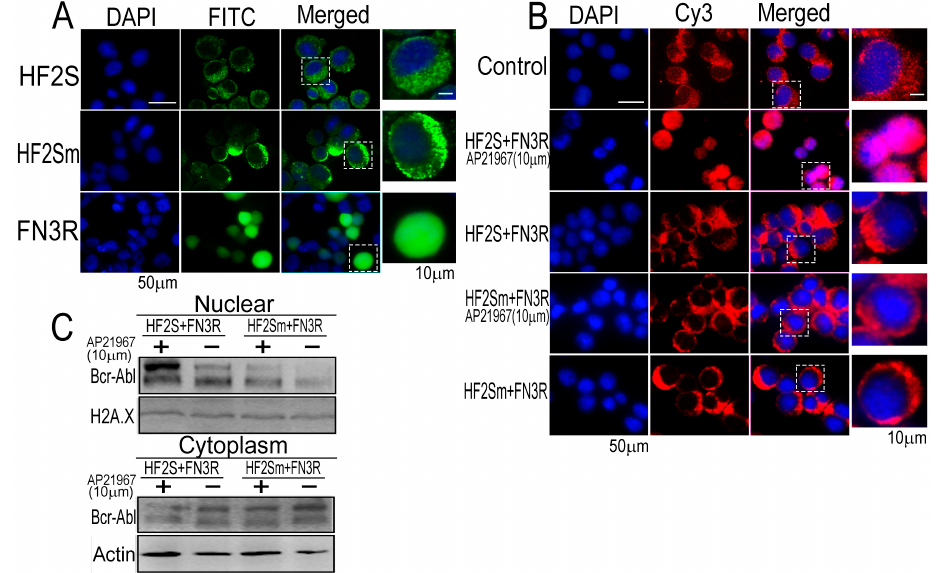
Figure 2. Bcr-Abl was imported into nucleus successfully by the nuclear transport system: ( A ) the location of exogenous HF2S, HF2Sm and FN3R fusion protein in K562 cells. Cells were treated with adenoviral Ad5/F35-HF2S, Ad5/F35-HF2Sm and Ad5/F35-FN3R, and stained with anti-HA/anti-Flag antibody fluorescein isothiocyanate(FITC)-labeled goat anti-mouse IgG, followed by DAPI (4 ′ ,6- diamidino-2-phenylindole) counterstaining and merged for each images; ( B ) immunofluorescence of Bcr-Abl with K562 cells treated with HF2Sm + FN3R, HF2Sm + FN3R + AP21967, HF2S + FN3R and HF2S + FN3R + AP21967. K562 cells without infection as control were applied to observe the location of Bcr-Abl; Scale bar was shown in the image with white line, and white dotted line box was indicated the corresponding magnified regions in ( A , B ); ( C ) the expression of Bcr-Abl in K562 cytoplasm and nucleus detected by Western blot.